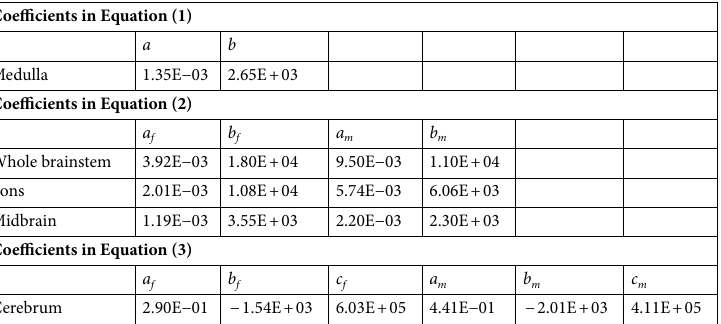
Table 3. Coefficients of the model equations. This table should be used with Eqs. (1), (2), and (3) in Table 2.